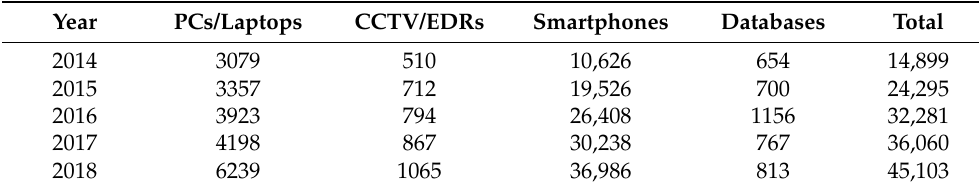
Table 1. Amount of digital evidence stored in South Korea as of 2020